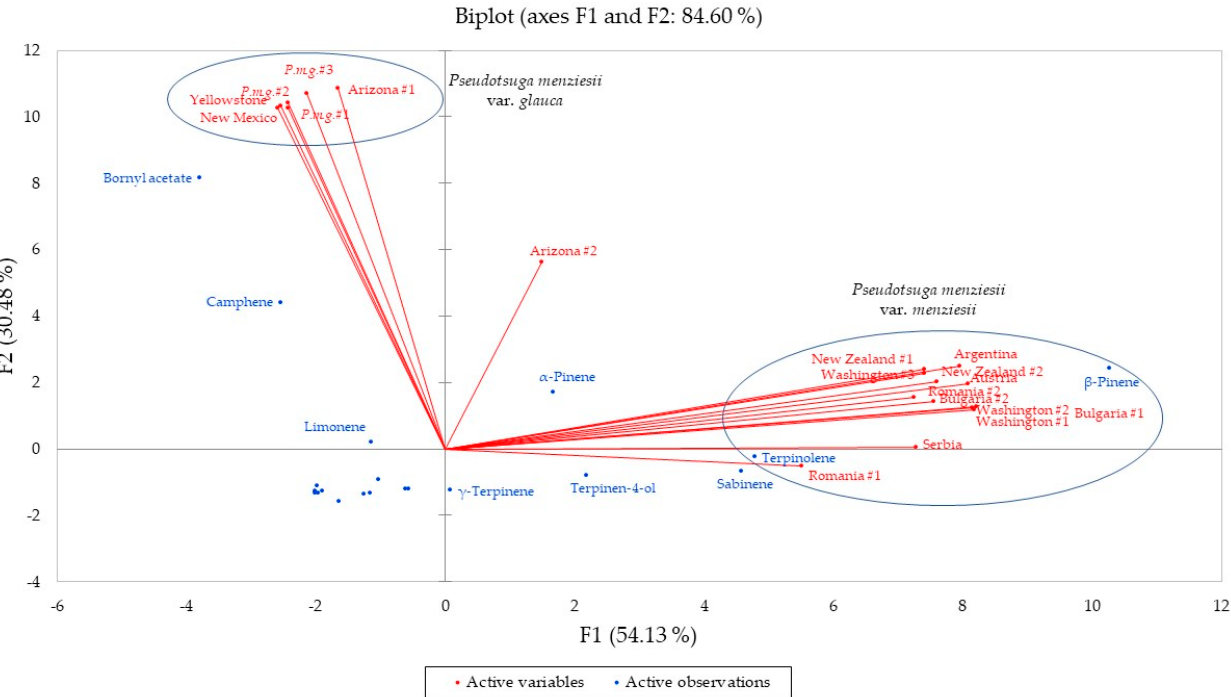
Figure 14. Biplot based on principal component analysis of Pseudotsuga menziesii chemical composi- tions. P.m.g. = Pseudotsuga menziesii var. glauca . APRC = Commercial essential oil samples from the Aromatic Plant Research Center collection.